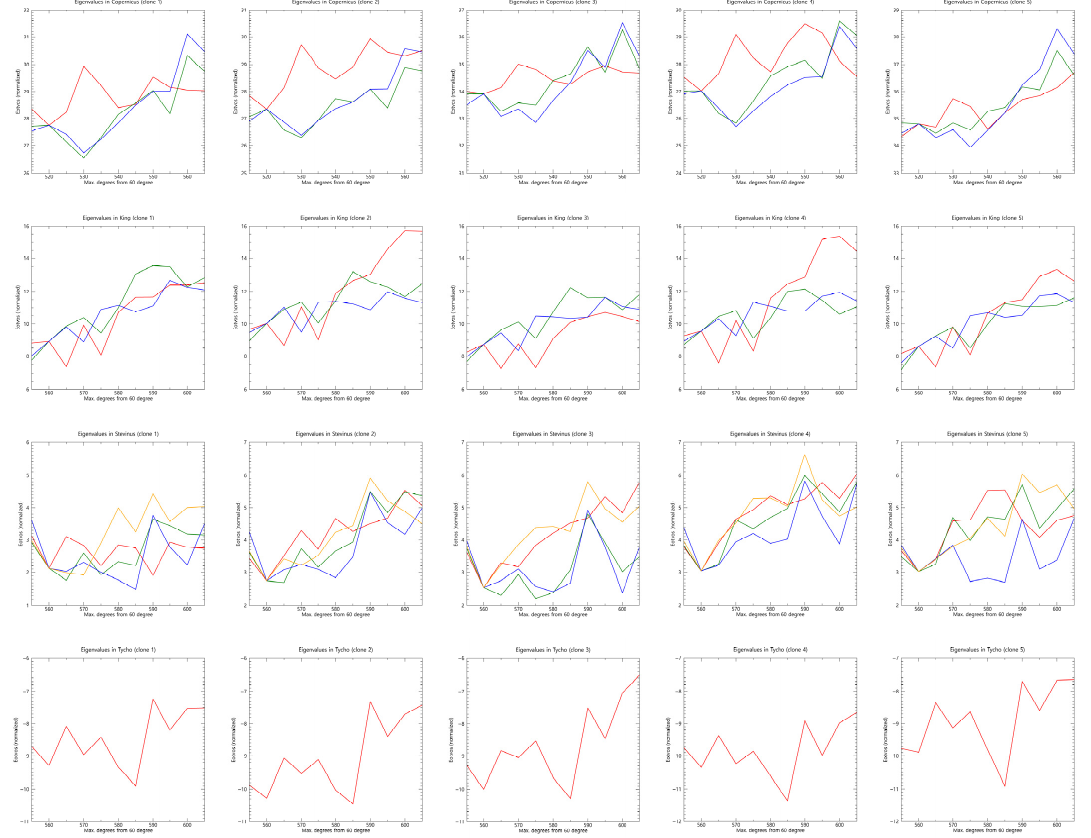
Figure A2. Clone model analysis results for the four regions in Section 3. A total of 5 were randomly selected from among 100 clone models. There are some points where the increasing trend is weak in Stevinus’ clone 3 and clone 5, but it can be seen that a positive trend appears in almost all of the clone models analyzed. Each plot is normalized as shown in Figures 5–7.